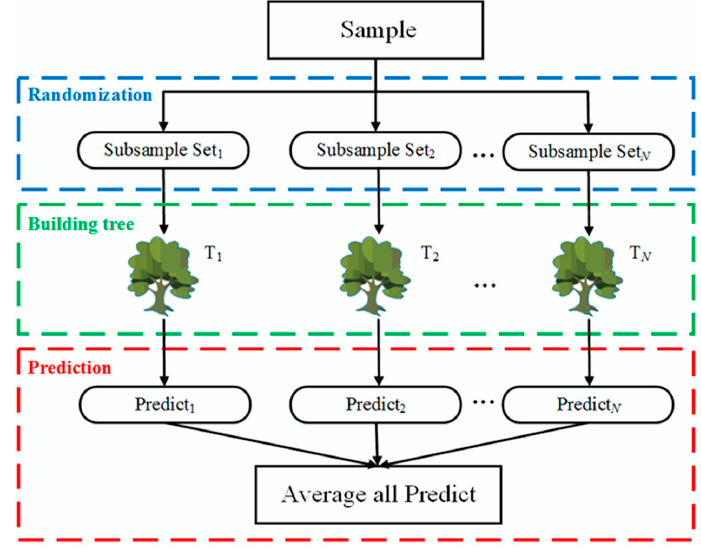
Figure 5. The structure of the RF algorithm.